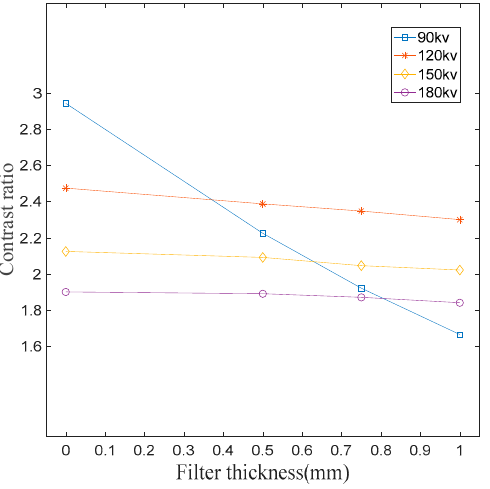
Figure 6. Relation curve between image contrast and filter thickness.